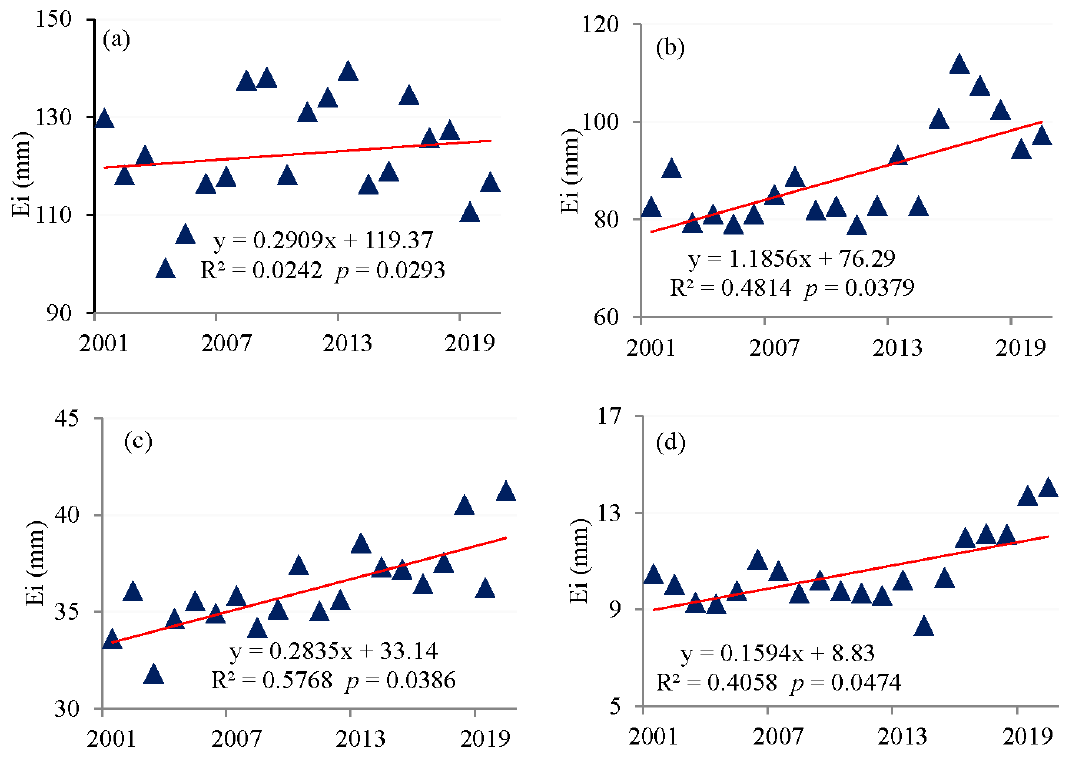
Figure 7. The temporal variation of Ei for different thermal regions during 2001 − 2020. ( a ) Tropical region; ( b ) subtropical region; ( c ) temperate region; ( d ) plateau climate region.